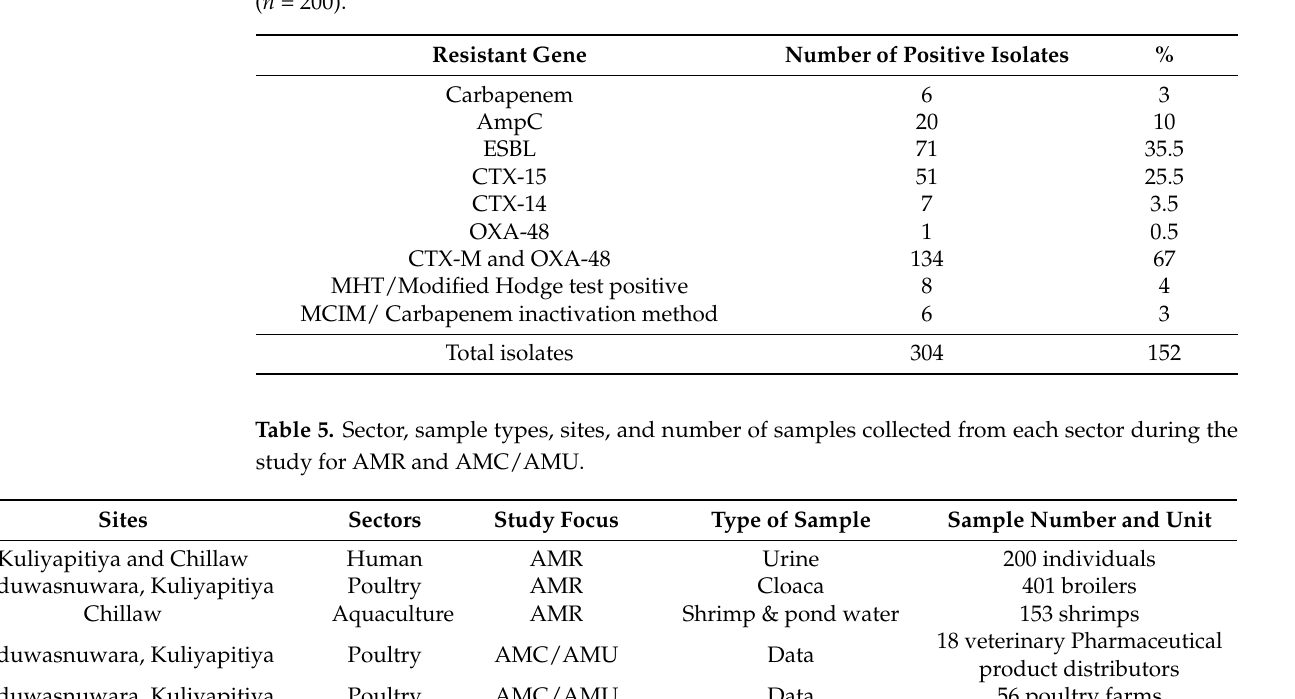
Table 4. Resistant genes identified in the selected isolates from humans, poultry, and aquaculture ( n = 200).